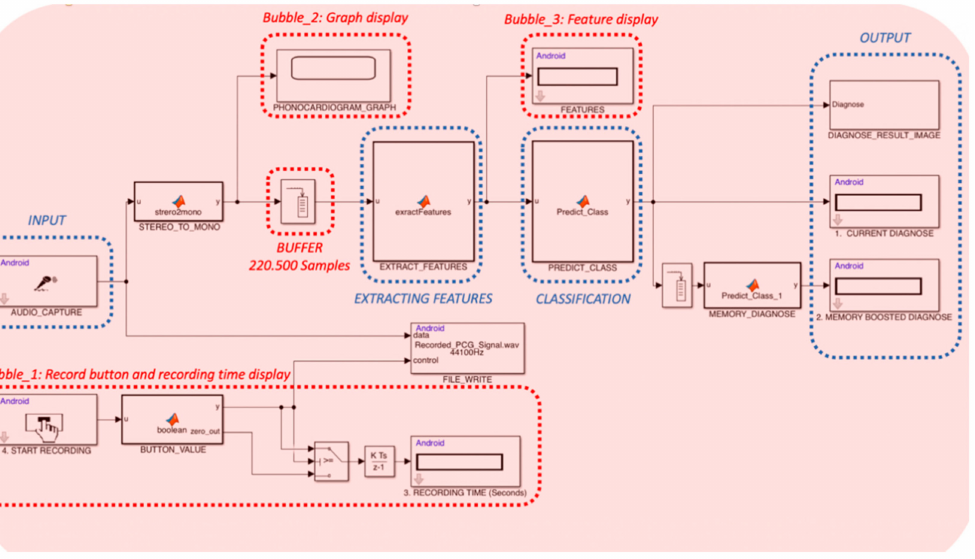
Figure 3. Simulink model of the